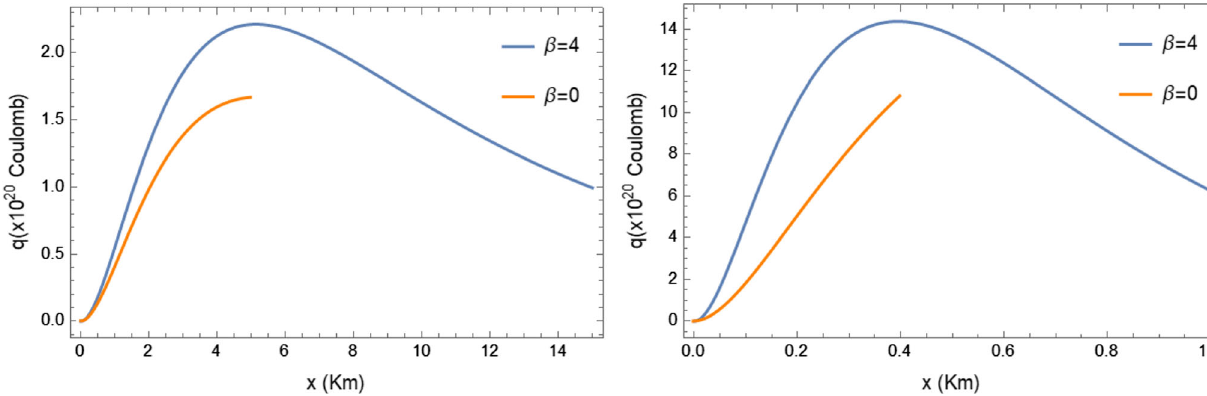
where κ 1 = ( − β + β C R 2 + 2 C R 2 + 2 ) and κ 2 = tan −